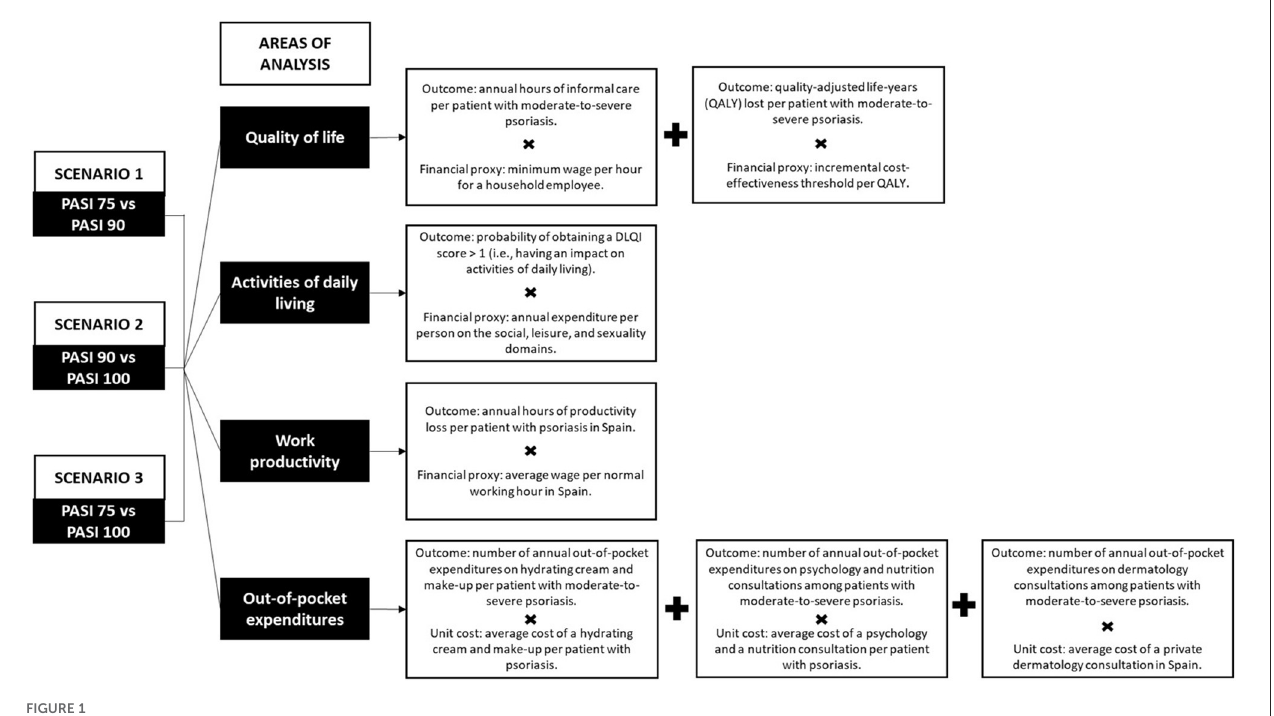
FIGURE1 PASI scenarios and areas of